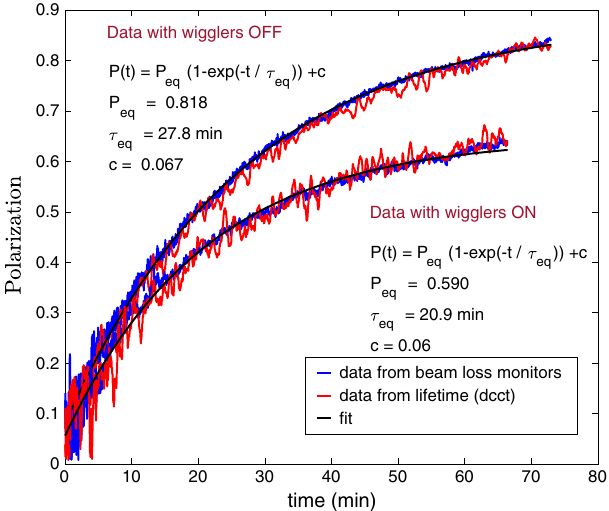
FIG. 1. Beam polarization as a function of time measured for wigglers off and on. A fit according to Eq. (9) calculates the maximum polarization level and the polarization time.